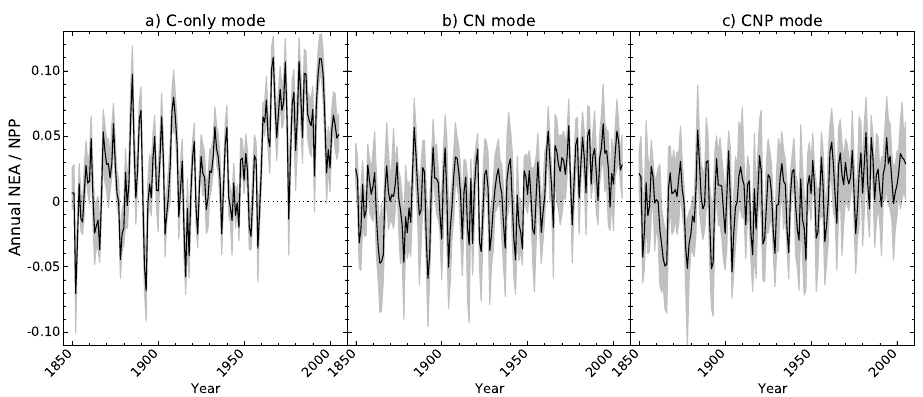
Fig. 4. Time series of net ecosystem accumulation (NEA) normalised by net primary productivity (NPP) for all combinations of a f W and a f T in a specific nutrient limitation mode as indicated. Negative values indicate a net sink. The black line represents the annual mean, while the shading corresponds to the range of the individual model versions within each mode.